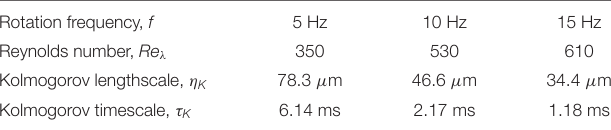
TABLE 2 | Fiber-dimensions ( L , d ) normalized by Kolmogorov length scale ( η K ), aspect ratio ( 3 = L / d ), and rotational Stokes number ( St ˙ p ) of fibers tested under three specific Reynolds number ( Re λ ) of the background